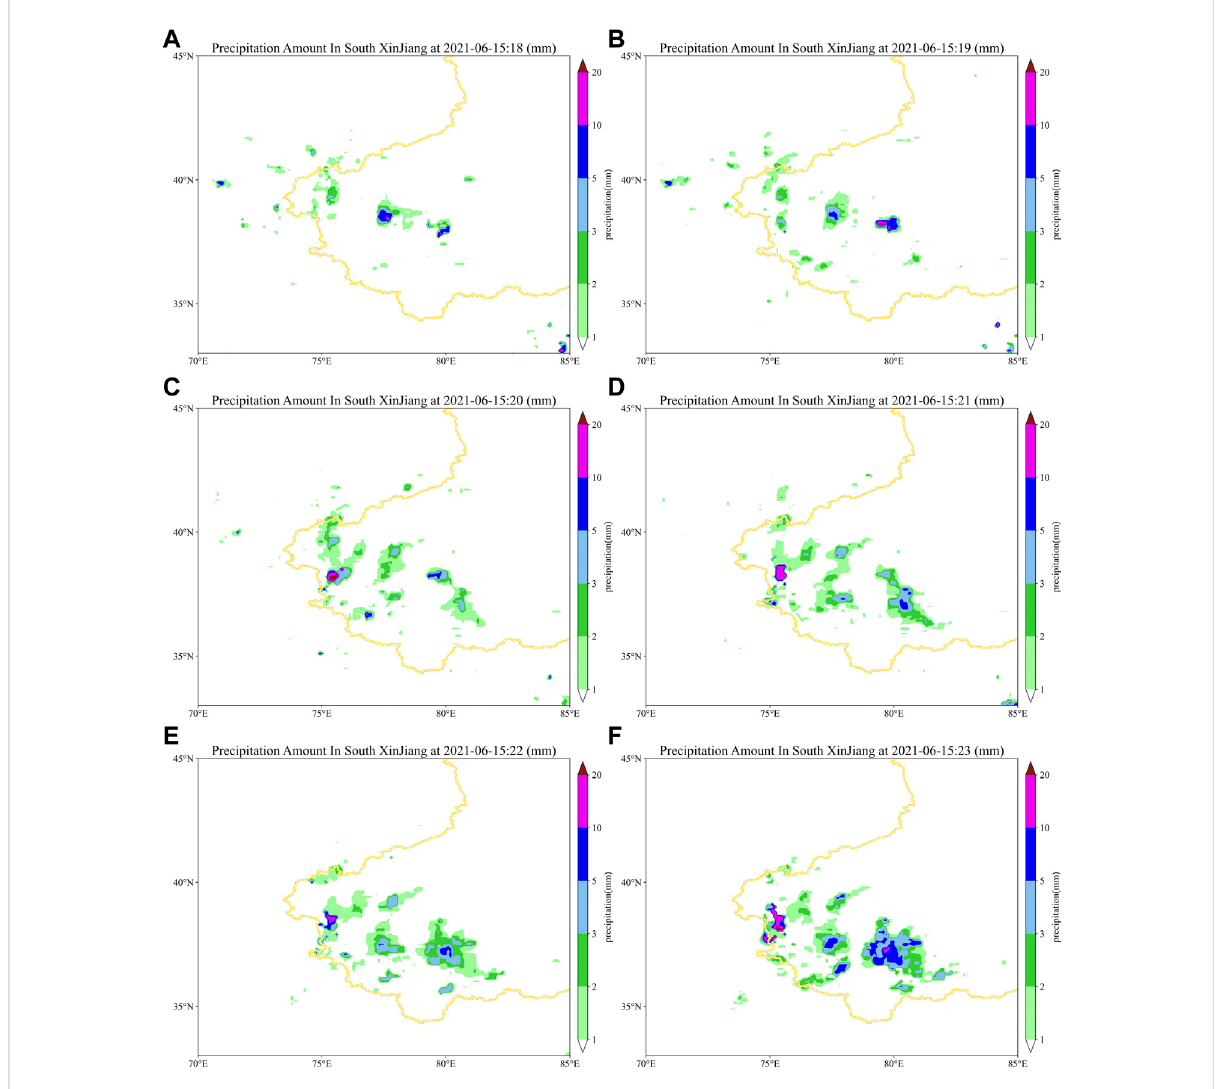
FIGURE 4 Hourly precipitation (mm) from 18:00 to 23:00 (A – F) on 15 June